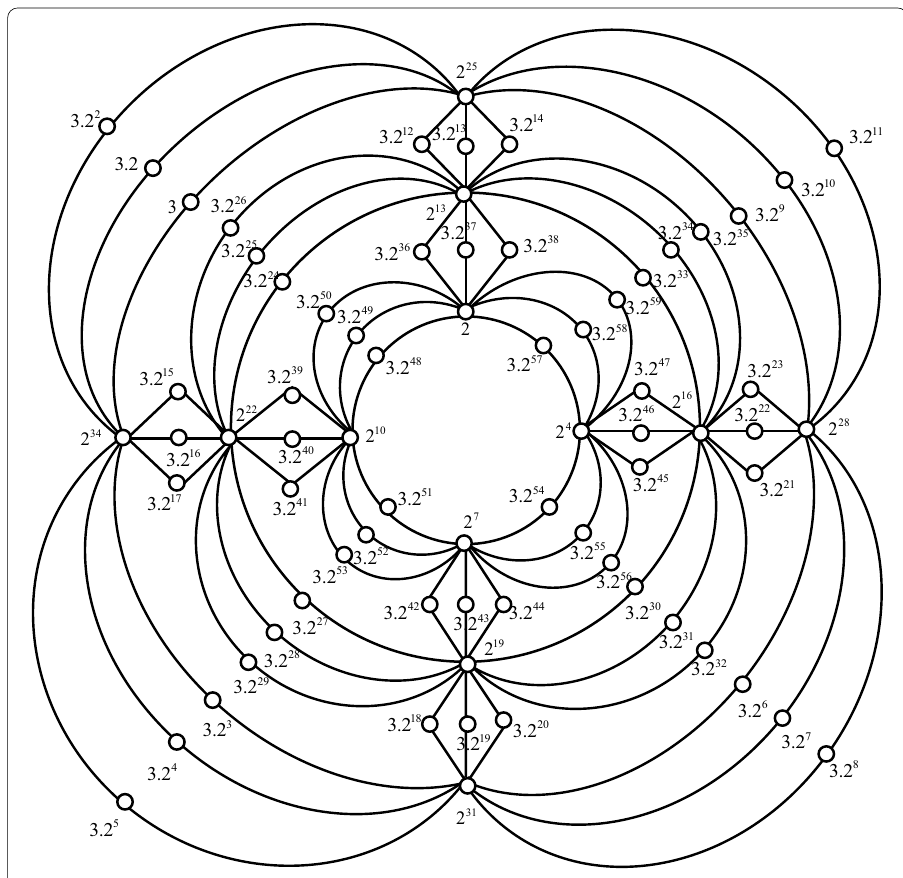
Fig. 8 24-Zumkeller labeling of SSD ( P 3 × P 5